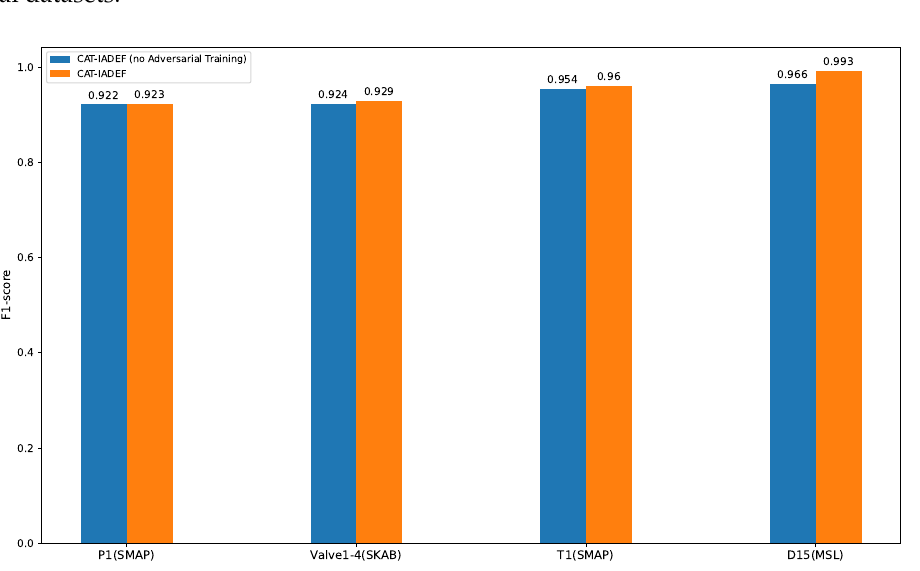
Figure 3. CAT-IADEF and CAT-IADEF (no adversarial training) performance